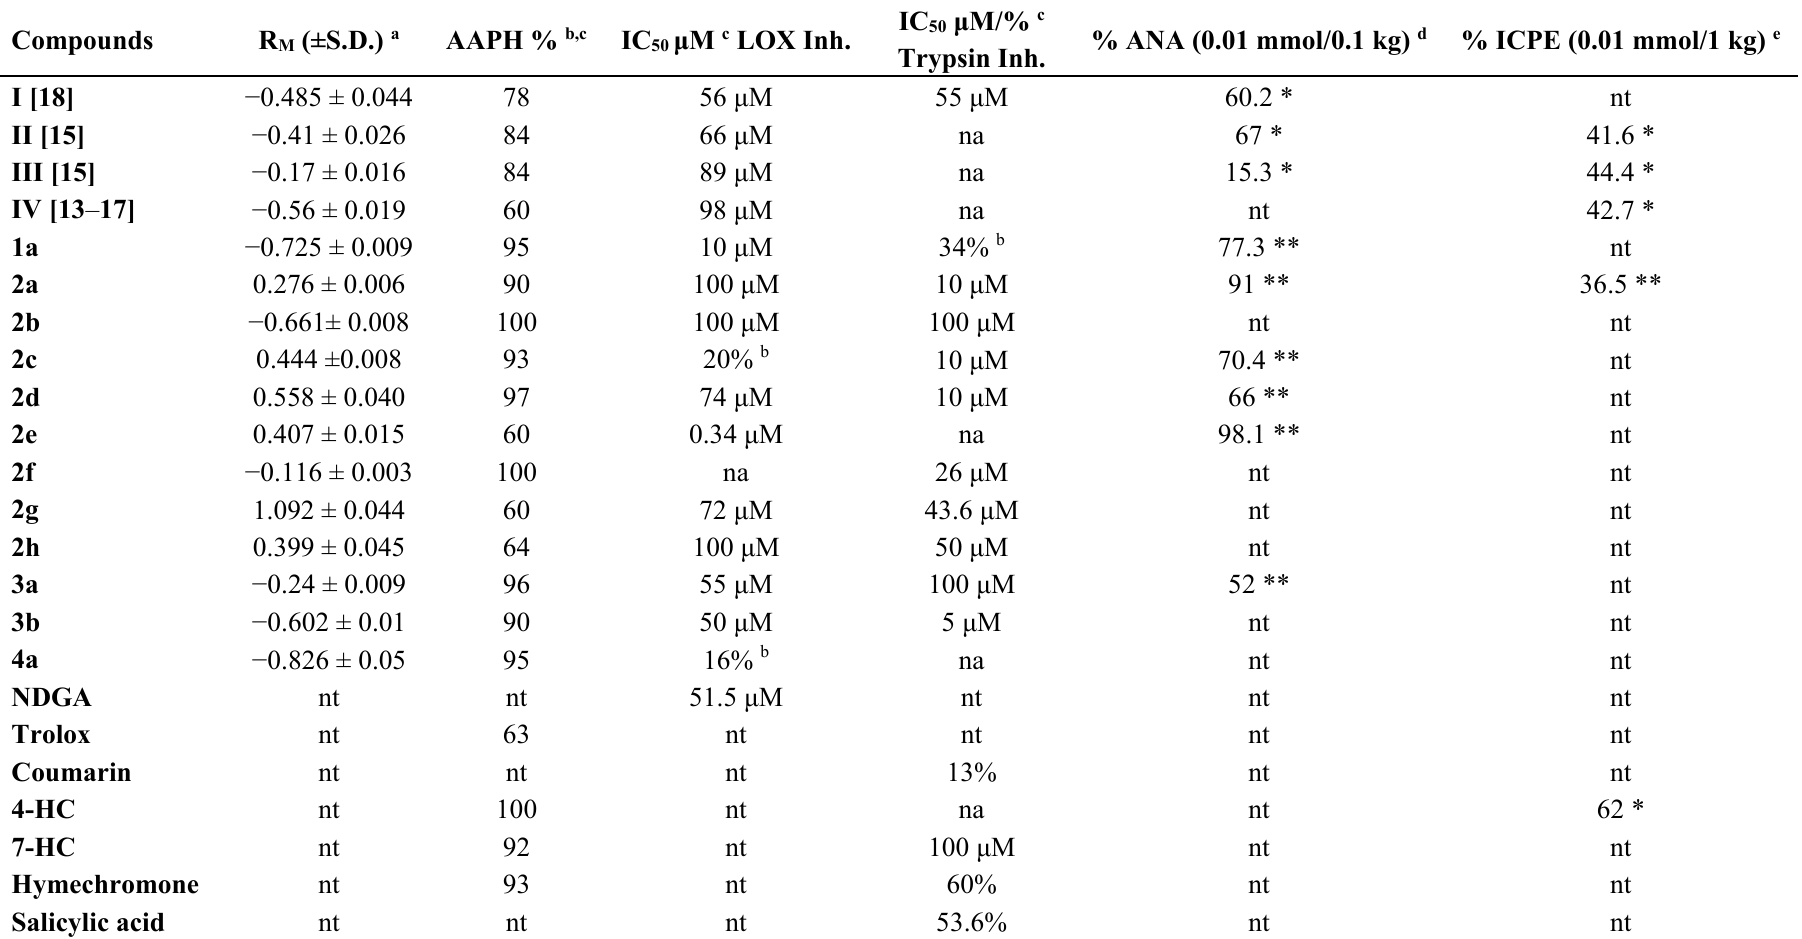
Table 1. Lipophilicity values (R M ) of cinnamic hybrids; % inhibition of lipid peroxidation (AAPH %); in vitro soybean lipoxygenase inhibition (IC 50 μΜ or % LOX Inh.); in vitro trypsin induced proteolysis inhibition (IC 50 or % Trypsin Inh.); in vivo analgesic-antinociceptive activity (% ANA); in vivo carrageenin-induced rat paw oedema inhibition (ICPE %).